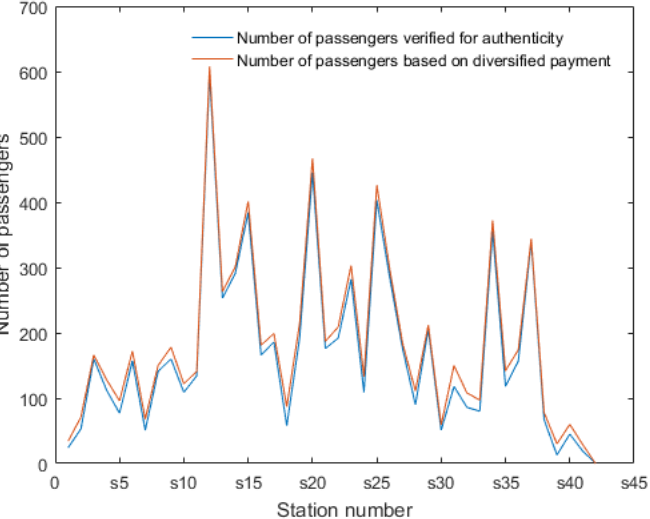
Figure 5. Statistical results of the authenticity verified daily passenger-flow data according to station number (downward bus lines).